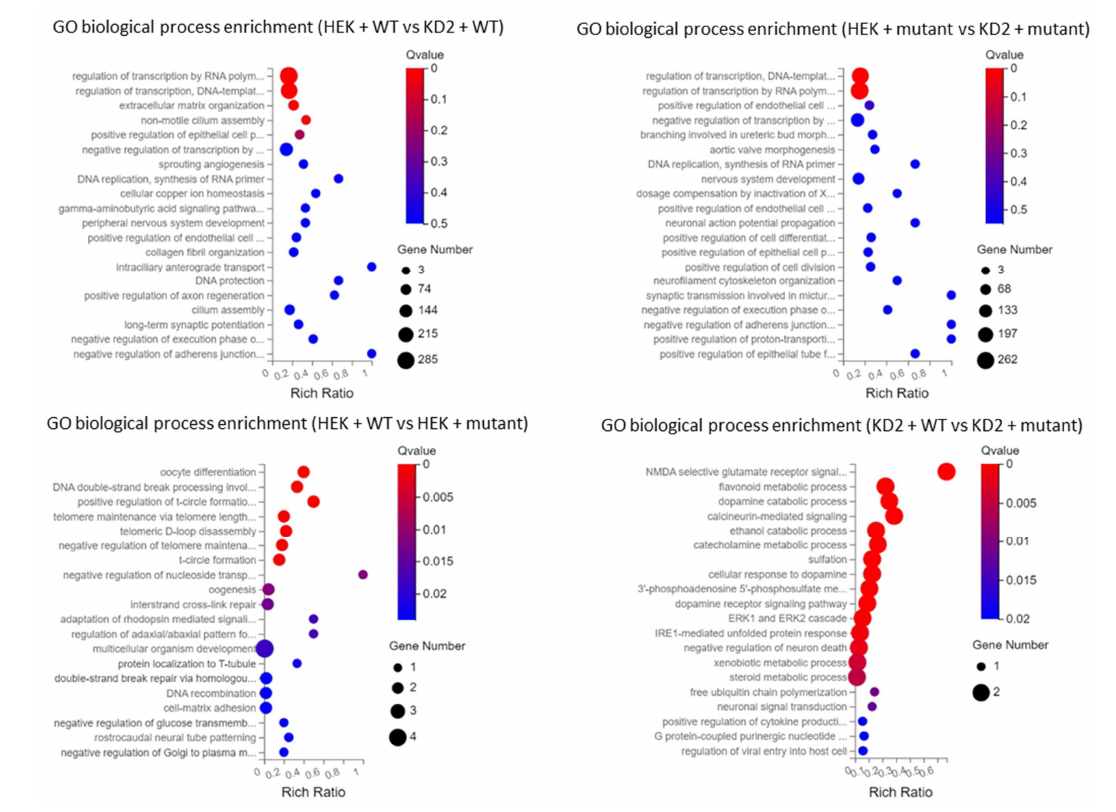
Figure 6. Bubble charts of GO biological processes enrichment in each comparison group. HEK + WT/mutant: WT HEK cells transfected with WT or mutant PBX1a plasmid. Clone KD2 + WT/mutant: KD2 cells transfected with WT or mutant PBX1a plasmid. When we compared mutant PBX1a -transfected cells to WT PBX1a -transfected cells (control vs. case analysis), only one gene (U2 small nuclear RNA auxiliary factor 1, U2AF1 ) was significantly downregulated in mutants (log2 fold change between case and control: −23.45). The WT-transfected cells and the mutant-transfected showed in fact strong differ-